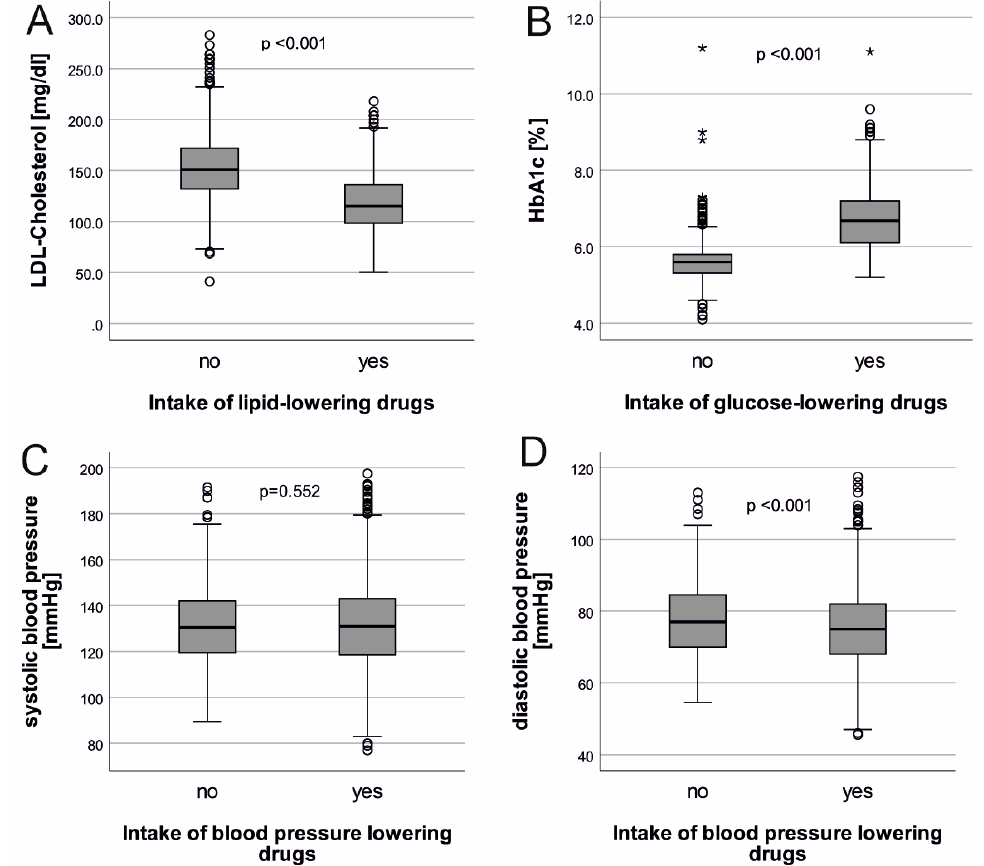
Figure 1. Distribution of LDL-cholesterol, HbA1c, systolic and diastolic blood pressure stratified by respective medication. Shown is the distribution of LDL-cholesterol stratified by intake of lipid- lowering drugs ( A ), of HbA1c stratified by intake of glucose-lowering drugs ( B ), and of systolic as well as diastolic blood pressure stratified by intake of antihypertensive drugs ( C , D ). Analyzed were 2215 AugUR participants. Shown are median, 25th and 75th percentiles (box), upper and lower whiskers ( ± 1.5 IQR), as well as outliers beyond ± 3 IQR as asterisks. Age- and sex-adjusted p -values from linear regression are given at the top of each panel, which tested the difference in the target parameter between participants with and without respective medication.